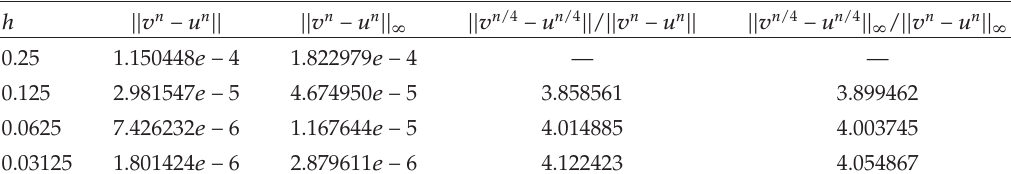
Table 5: The errors of numerical solutions at t (cid:9) 10 with τ (cid:9) 0 . 1 when p (cid:9) 8.